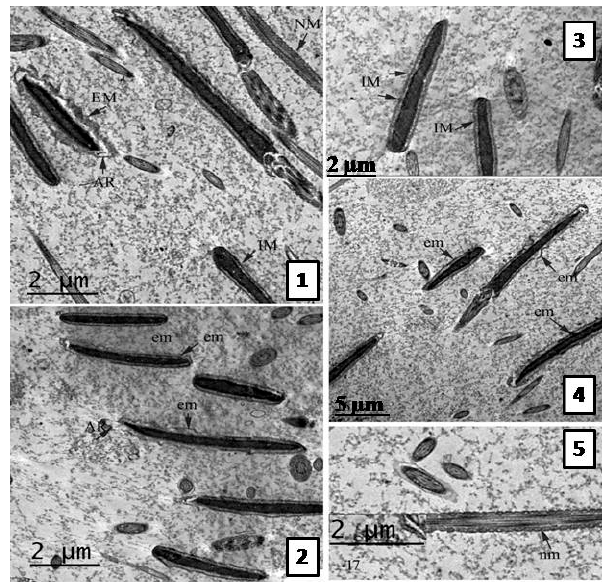
Figure 5. TEM photomicrographs of bull sperm head in groups treated with 1.5 µg A. harveyi extract. ( 1 – 5 ) Different sagital sections representing cell membrane of acrosomal cap with intact plasma membrane (IM) in many sperms of the same section. Early degree of cell membrane extension also was found (EM). The electron dense mitochondria is regularly placed in both transverse and longitudinal sections